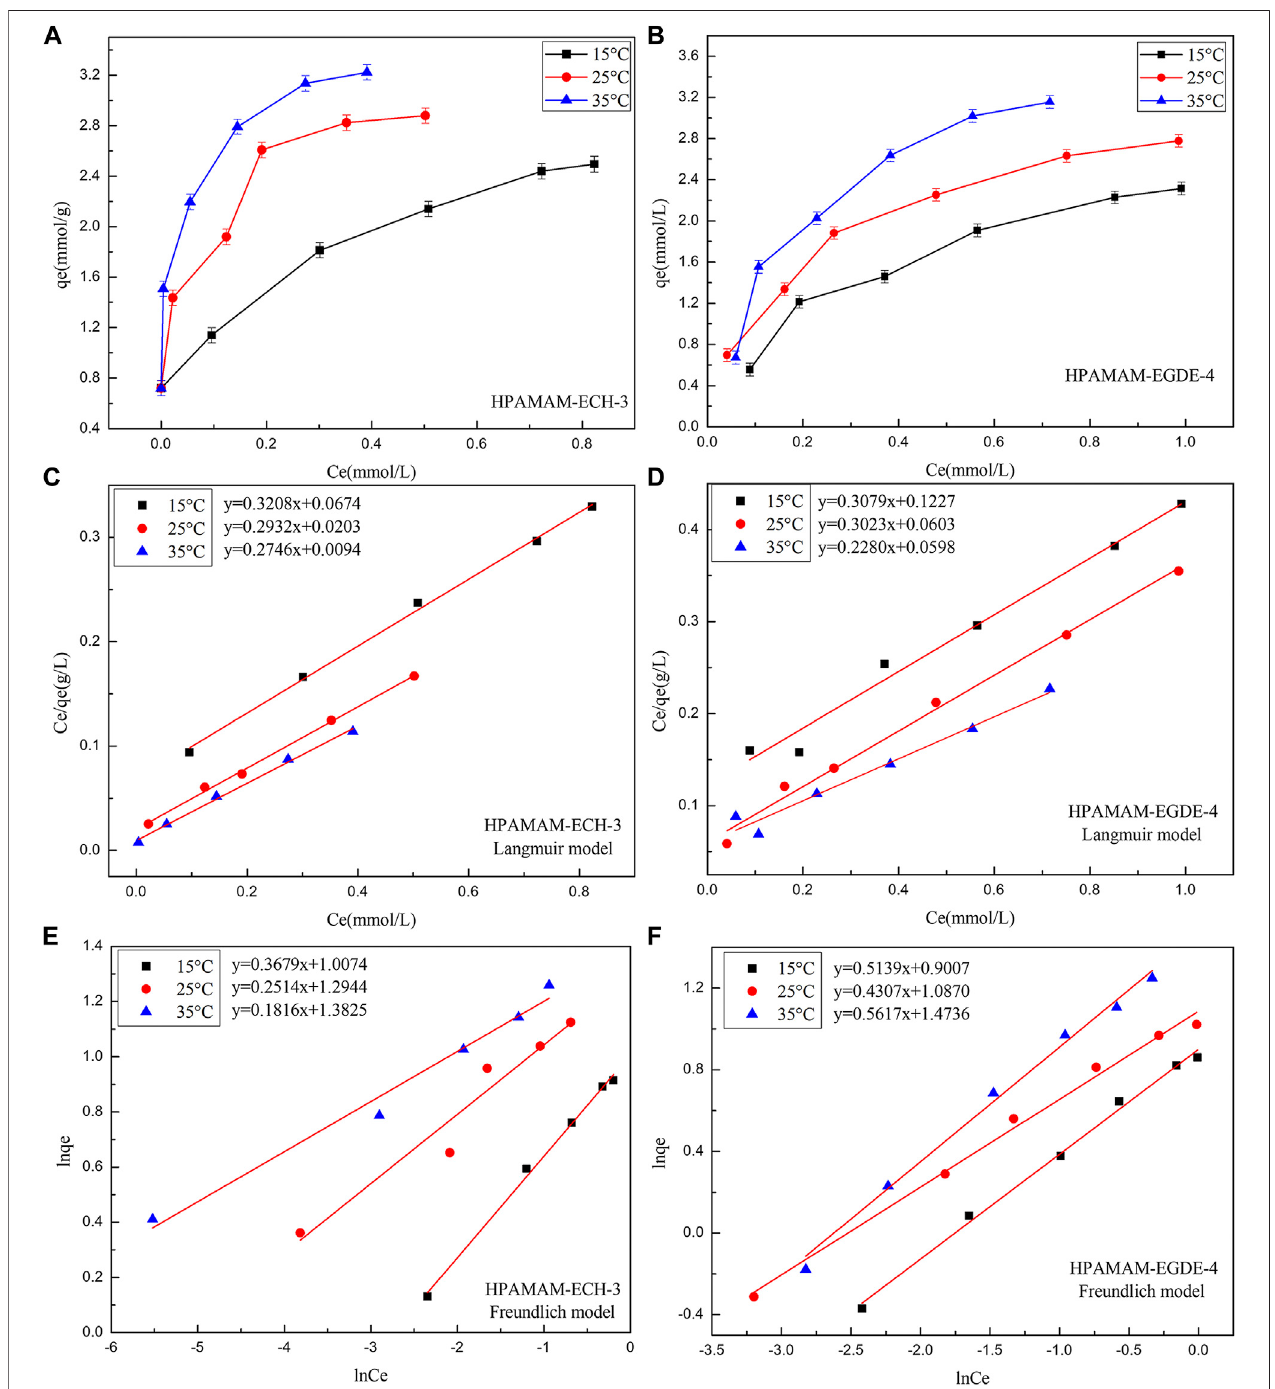
FIGURE 6 | (A , B) The adsorbing capacities, (C , D) the Langmuir isotherms and (E , F) the Freundlich isotherms of HPAMAM-ECH-3 and HPAMAM-EGDE-4 at different initial concentrations and temperatures, pH 5.0 for Hg(II).